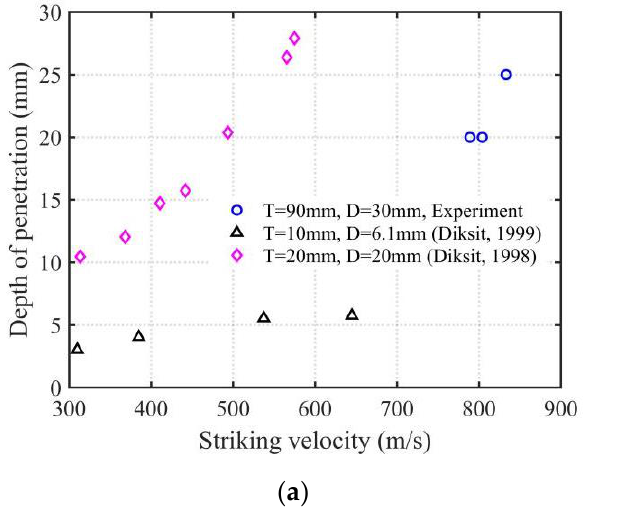
Figure 10. Variation of the penetration depth with the striking velocity at different obliquities: ( a ) 15° obliquity and ( b ) 30° obliquity.